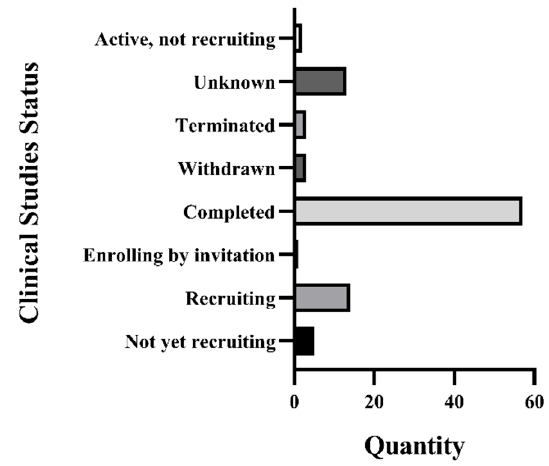
Figure 2. Recruitment status of GBE clinical trials.